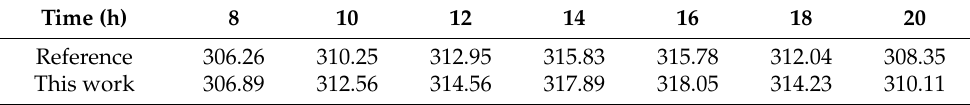
Table 5. The wall TEM in the middle obtained from the present work and experimental results. Time